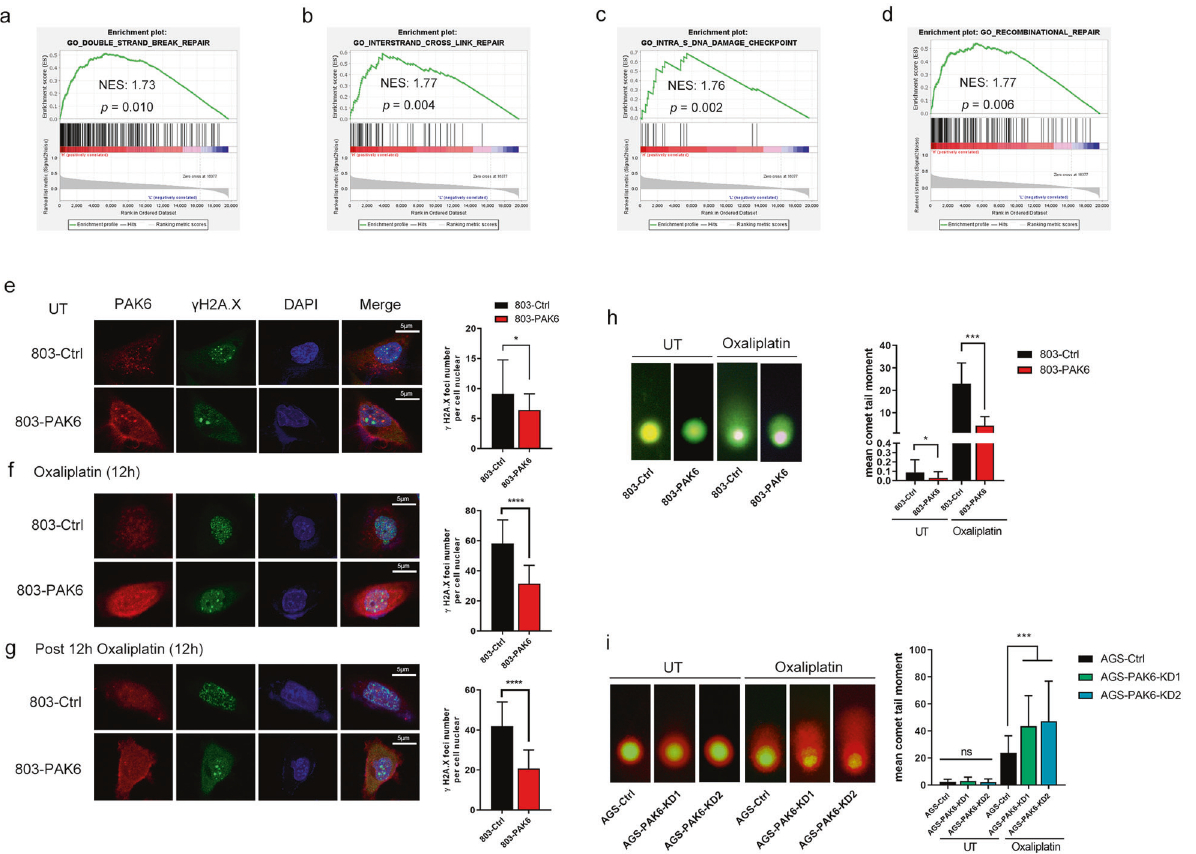
Fig. 3 PAK6 reduces DNA damage induced by oxaliplatin in GC cells. a – d Go analysis of the gene pathways differentially expressed between PAK6-high expression and PAK6-low expression gastric cancer samples in TCGA database. Four representative GSEA-enrichment plots were shown. e Left: PAK6 staining (red), γ H2A.X staining (green), and DAPI staining (blue) in the control cells and PAK6 overexpression cells in 803 GC cell line; Right: Quanti fi cation of mean γ H2A.X foci per cell. f Left: PAK6 staining (red), γ H2A.X staining (green), and DAPI staining (blue) in the control cells and PAK6 overexpression cells in 803 GC cell line after treated with oxaliplatin for 12 h; Right: Quanti fi cation of mean γ H2A.X foci per cell. g Left: PAK6 staining (red), γ H2A.X staining (green), and DAPI staining (blue) in the control cells and PAK6 overexpression cells in 803 GC cell line after recovery from oxaliplatin treating (12 h) for 12 h; Right: Quanti fi cation of mean γ H2A.X foci per cell. At least 30 cells per group were included for the counting and quanti fi cation. h , i Left: Representative images of neutral comet assays of control cells, PAK6 overexpression cells, and PAK6 knocked down cells in the absence and presence of oxaliplatin; Right: Quanti fi cation of the percentages of DNA tail moments. At least 30 cells per group were included for the counting and quanti fi cation. UT: untreated. *: P <